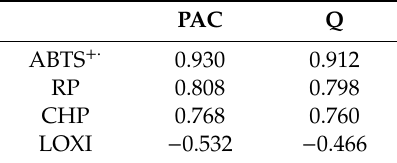
Table 2. Pearson’s correlation coe ffi cients of the phenolic compound (PAC and Q) content and antioxidant and anti-inflammatory activities of pastas fortified with onion skin